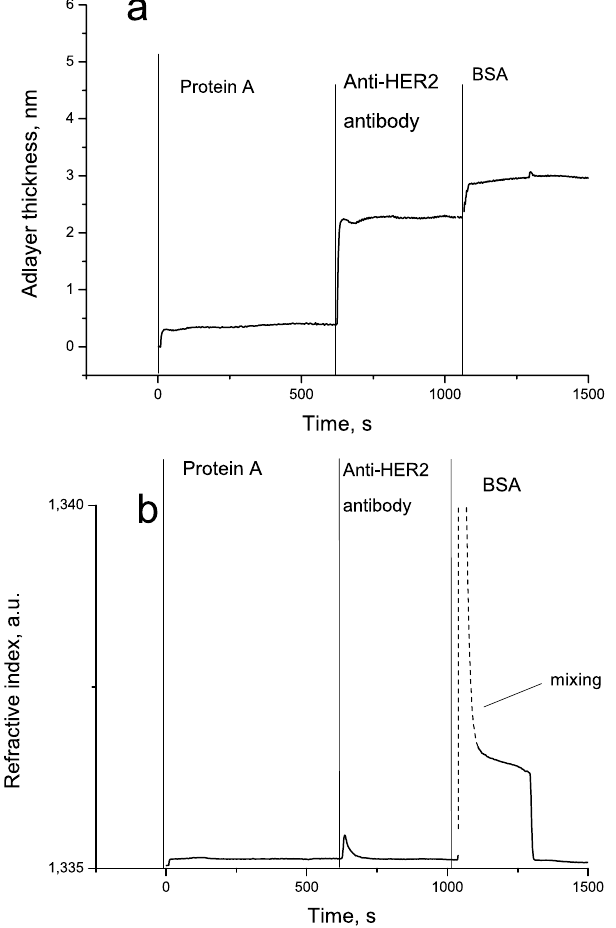
Figure 3. The sensorgram reflecting a typical formation of the sensor surface. (a) The adlayer thickness signal; the SiO 2 -based surface of the PC chip is conjugated with protein A via a combination of APTES and glutaric aldehyde; the next step is deposition of IgG antibodies on the protein A layer; after that, BSA is used to